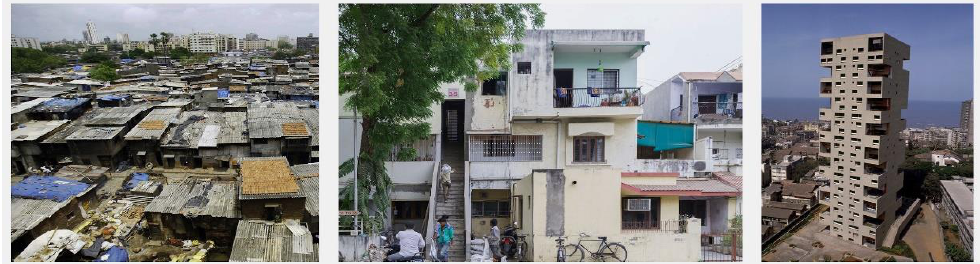
Figure 1. Context of global urban development and densification. From left to right: informal, semiformal, and formal construction typologies.